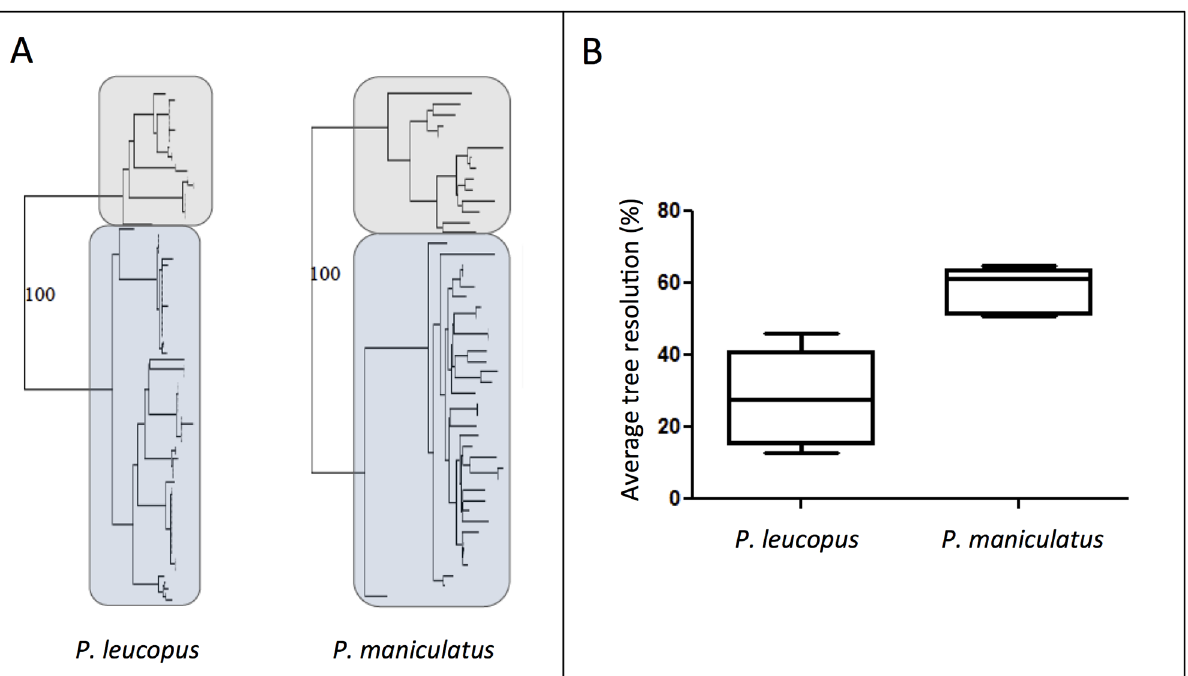
Fig 2. (A) Phylogeographic trees estimated by neighbor-joining from the combined sequences of 5 mtDNA regions; (B) and average topological resolution of the trees obtained for each five marker. The north-shore clades are framed in grey and the south-shore clades in blue. Boostrap support values are shown for the NS/SS